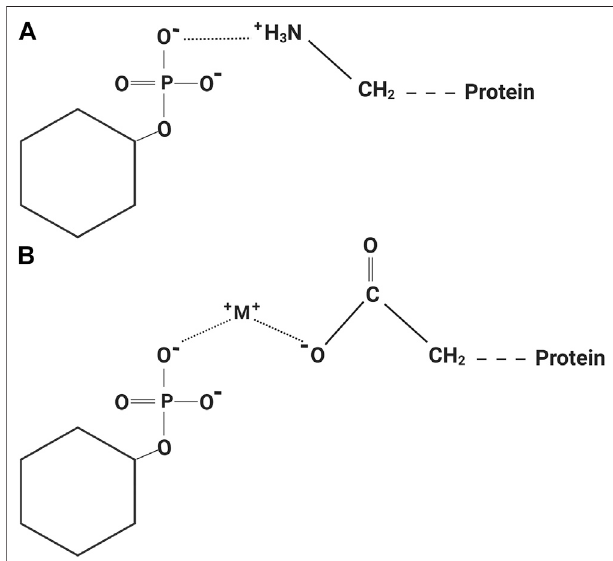
FIGURE 2 | (A) Binary protein-phytic acid complex at a pH below the isoelectricpointoftheprotein. (B) Ternaryprotein-cation-phyticacidcomplexat a pH above the isoelectric point of the protein. This image was created using BioRender (https://app.biorender.com/).